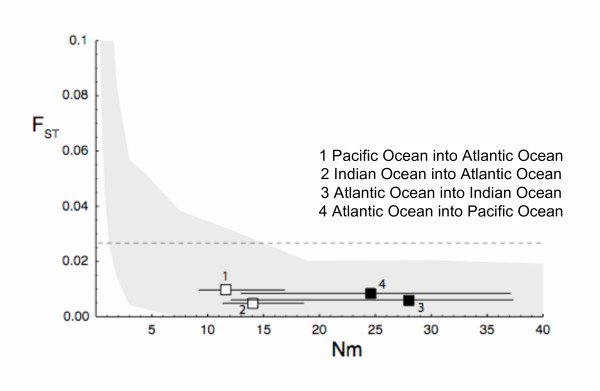
FST values estimated from simulated data. The X-axis shows the number of immigrants per generation Nm that was used to simulate 100 data sets for 20 equidistant points along the X-axis. The gray area covers the 95% confidence area. The filled and open squares show from and into Atlantic Ocean comparisons, respectively. 95% confidence intervals are shown. The dotted line shows the maximal FST value detected (corresponding to Canada2 versus Pacific pairwise comparison)